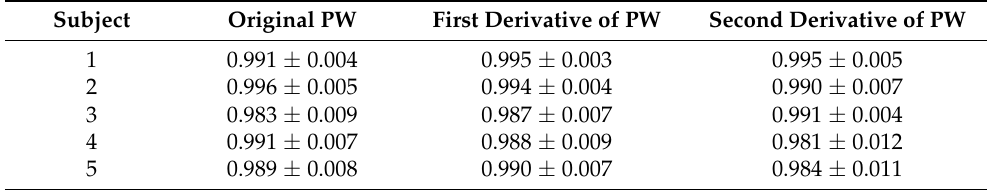
Table 3. Mean and SD of beat-by-beat normalized cross-correlations between PW signals acquired by FCG and PPG-R sensors.